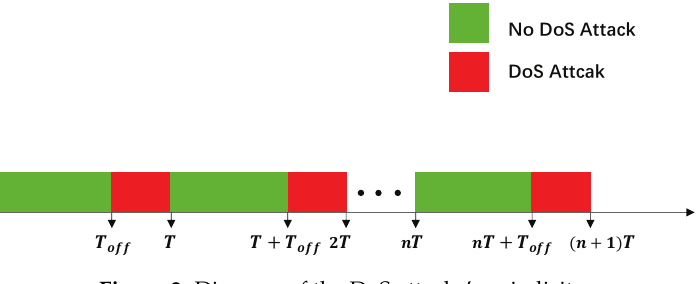
Figure 3. Diagram of the DoS attacks’